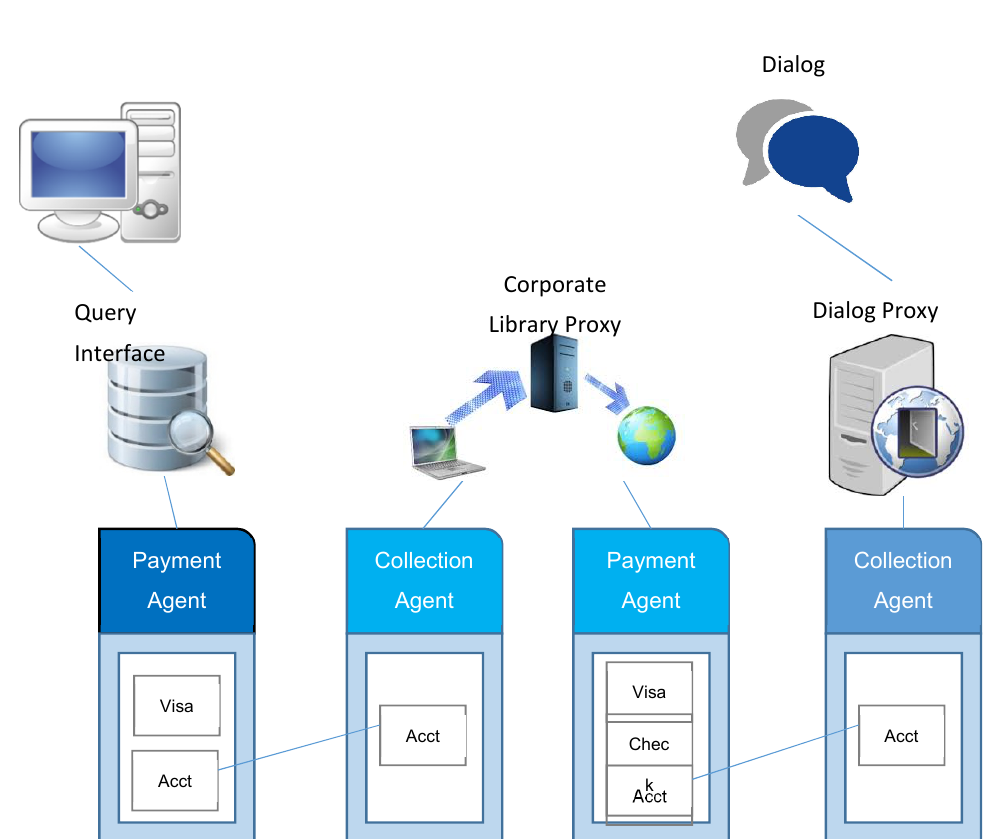
Figure 4. General network infrastructure (based on information of Interpay).